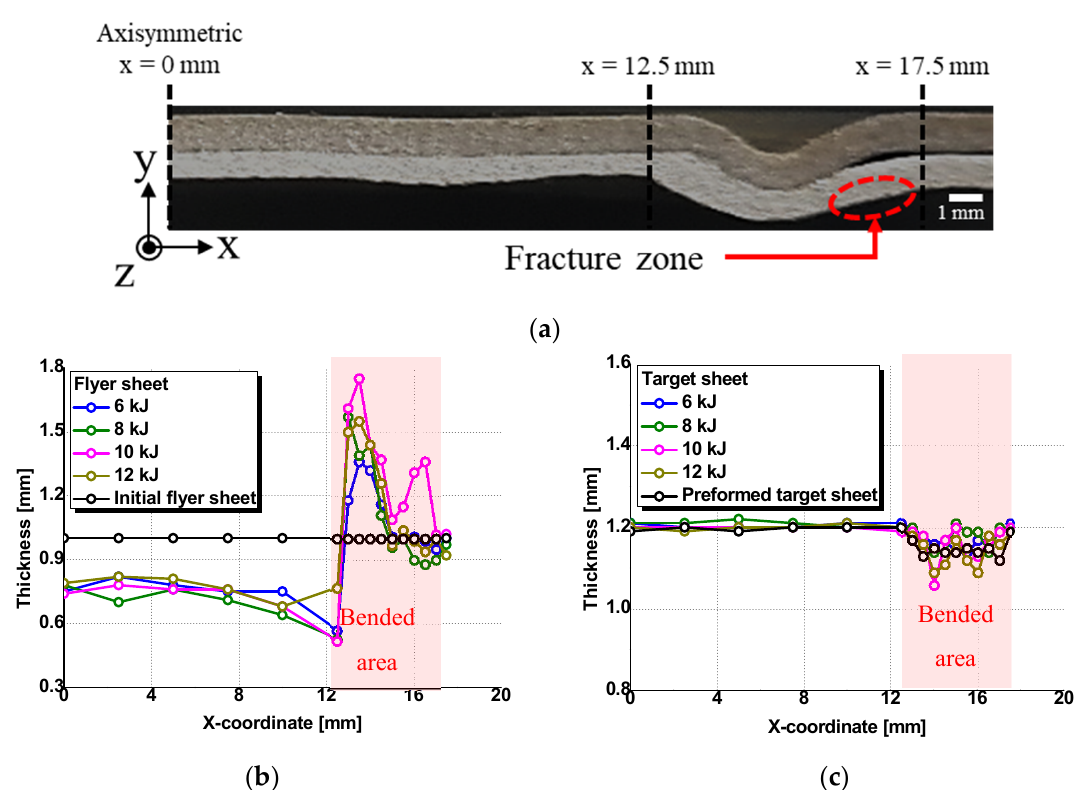
Figure 14. Thickness distribution of welded specimen with increase of input energy: ( a ) sectional view of welded surface; ( b ) thickness distribution along flyer sheet; ( c ) thickness distribution along target sheet.